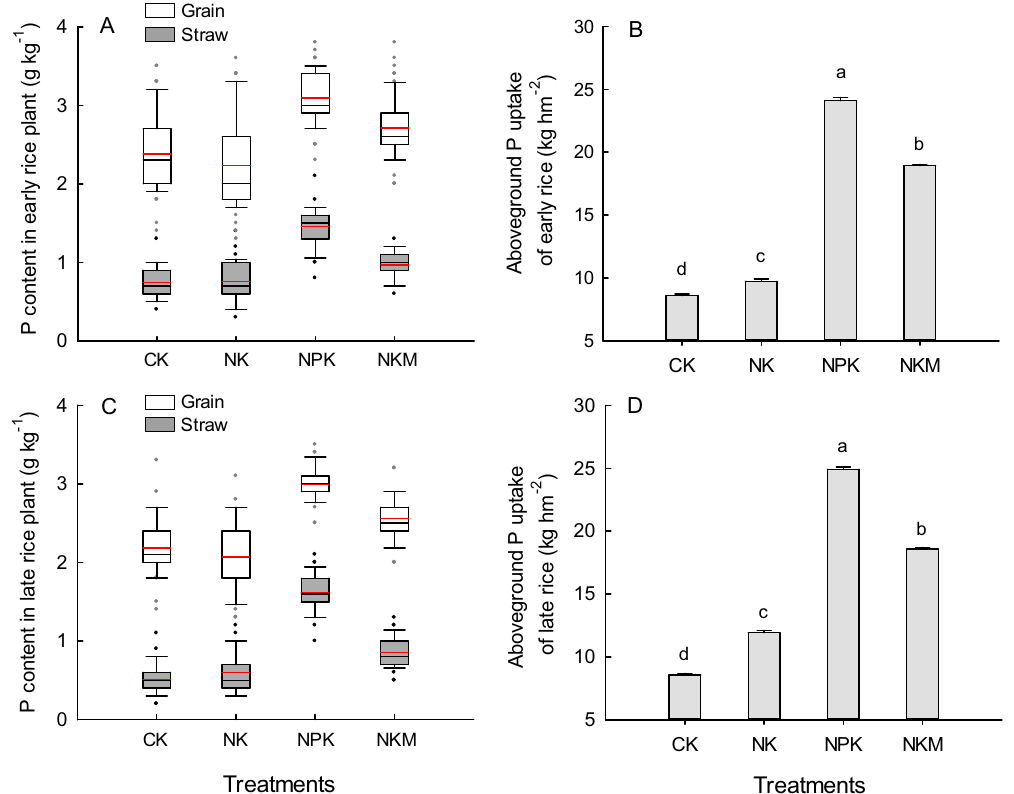
Figure 3. Distribution of P content in plant of early ( A ) and late rice ( C ), and the annual mean aboveground P uptake of early ( B ) and late rice ( D ) under different fertilization treatments CK, NK, NPK and NKM across 35 years. White and gray boxes indicate P content in grain and straw, respectively, and red lines indicate the mean value in ( A , C ). Error bars are standard error of three replicates, and different lower case letters indicate significant differences for the annual mean aboveground P uptake between treatments at p < 0.05 in ( B , D